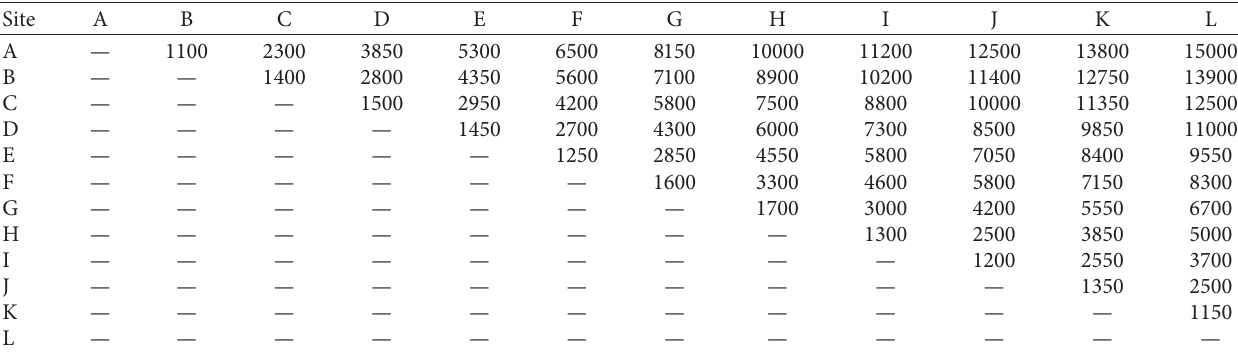
Table 3: The distance matrix between stations (m).